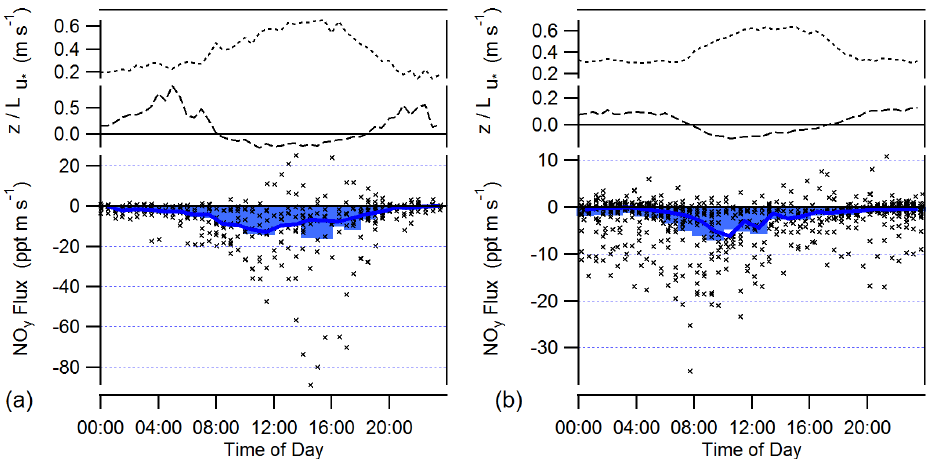
Fig. 9. Diurnal median u ∗ , MO z L − 1 , and eddy covariance NO y fluxes for (a) PROPHET and (b) HFWR. In the lower panel, bars represent the hourly mean, the solid line represents the median, and the markers represent individual